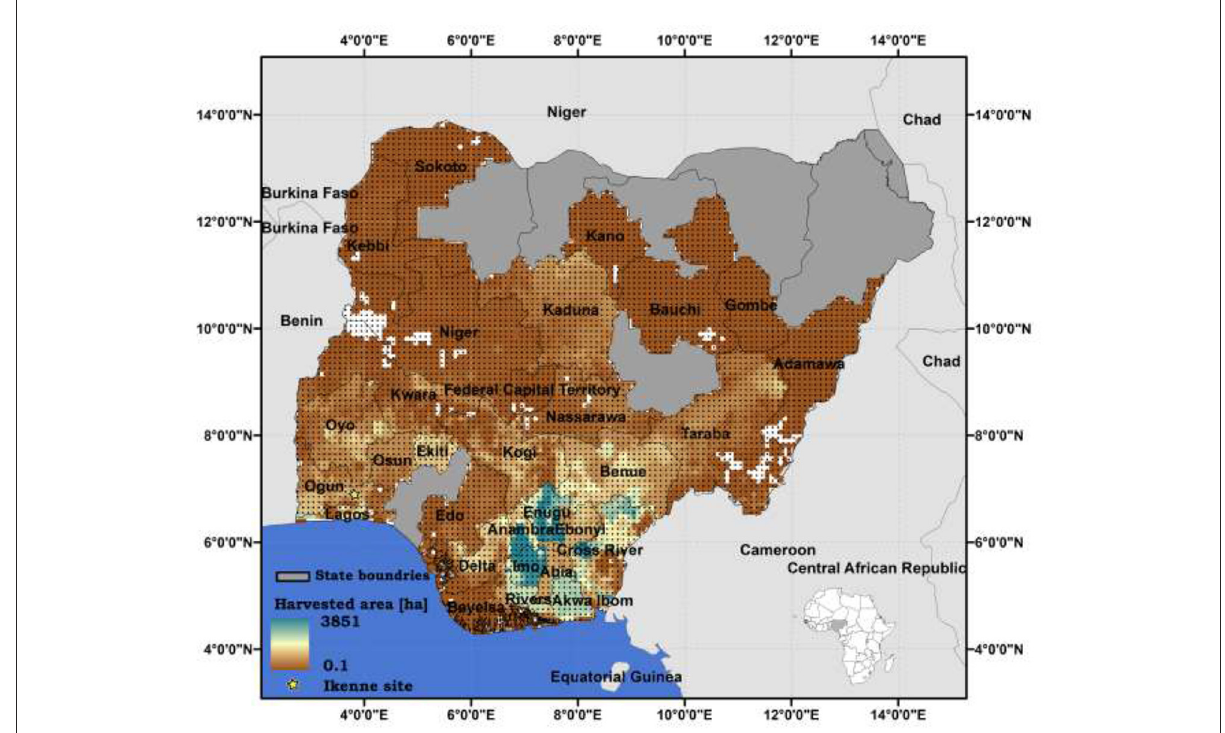
FIGURE2 Nigeria map highlighting the simulation units of 30 states and the Ikenne experimental